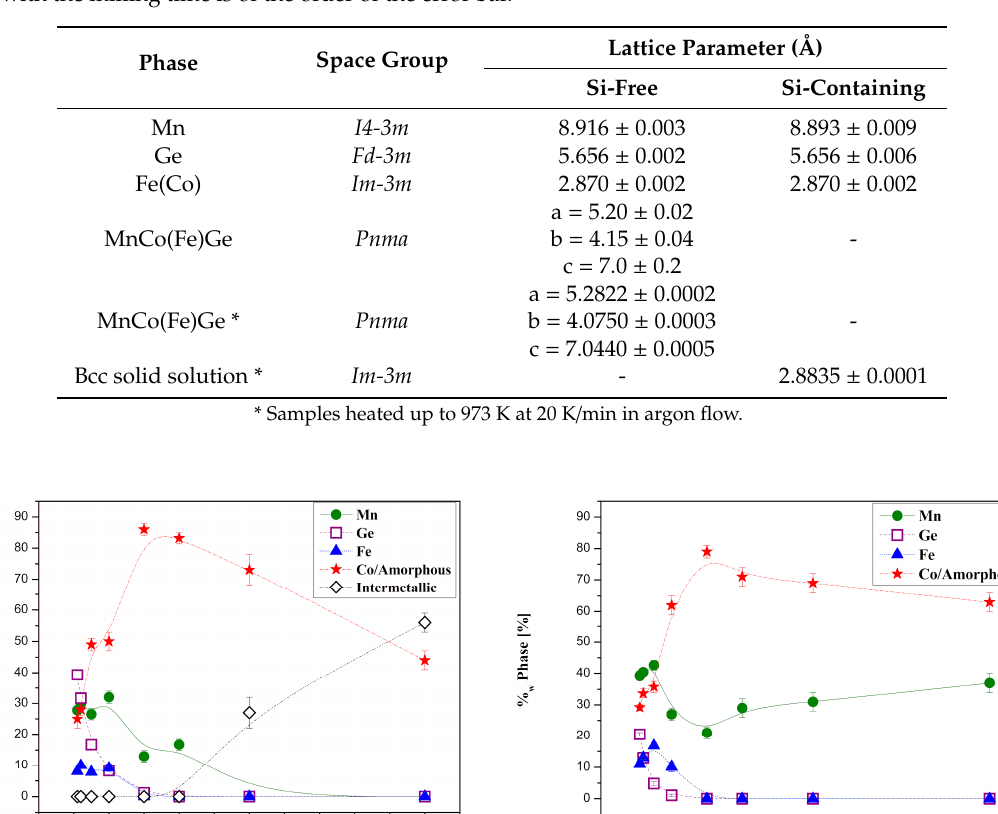
( a ) ( b ) Figure 3. Crystal size from XRD Rietveld analysis as a function of the milling time: ( a ) Si-free alloy ( b ) Si-containing alloy. The fraction of the diamond-like Ge phase ( Fd-3m space group) exponentially decreased with milling time for both studied compositions. The content of bcc-Fe-type phase ( Im-3m space group) initially reached values above the starting weight fraction of Fe, indicating the migration of other atoms (mainly Co and Si) to this phase. After 10 h of milling, the decrease of the weight fraction for this phase was clear and was no longer detected by XRD after 20 h milling. The evolution of the Mn phase fraction depends on the Si content of the sample. Whereas for Si-free alloy, the Mn-type phase was no longer detected by XRD after 50 h milling; for Si-containing alloy, the Mn-type phase remained almost constant (or even increased) from 10 h up to the maximum time explored in this study (100 h). As written above, Rietveld fitting showed that the crystal size of the Co-type phase ( P6 3 /mmc space group) rapidly decreased with milling time (below 2 nm after 5 h milling for Si-free alloy and after 10 h milling for Si-containing alloy). Therefore, the diffraction maxima ascribed to this phase no longer describe a crystalline phase but rather amorphous halos ascribed to an amorphous phase. The distinction between crystalline Co-type and Co-base amorphous phase is not clear. Therefore, the two phases are represented together in Figure 2. Lattice parameters did not change significantly with the milling time but the average values could differ with respect to the values of the pure phases. This should indicate that e.g., Co migration to bcc Fe occurs at the early stages of milling, in agreement with the higher fraction measured for this phase (8–10 wt. %) with respect to the nominal Fe fraction (6.0 and 6.8 wt. % for the alloys without and with Si). In the case of Ge, the measured lattice parameter agreed with that of the pure phase, indicating that this element preserves its purity during its comminution. In the case of the Mn phase,